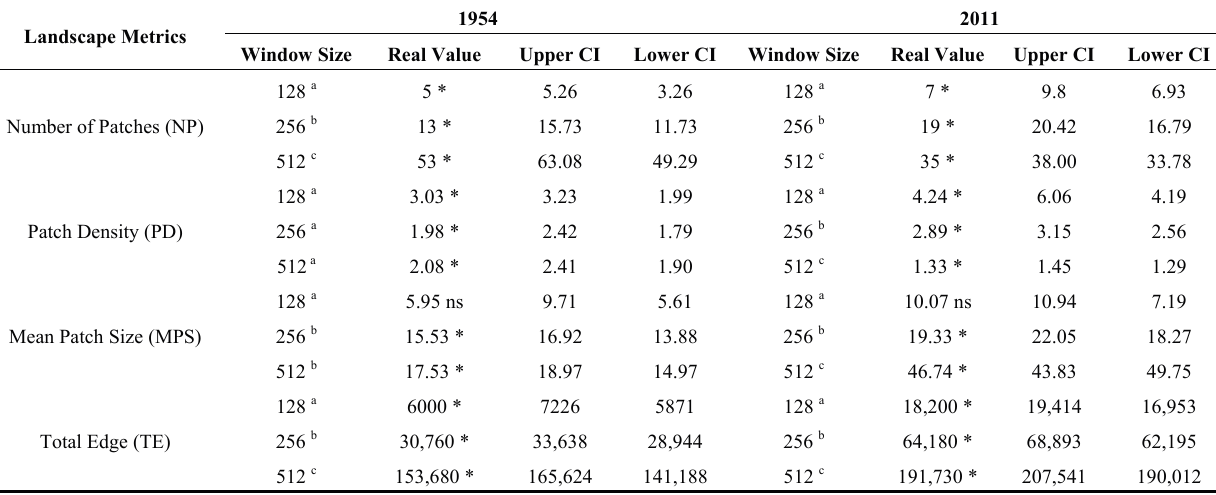
Table 2. Real values of pattern metrics obtained from three different map extents (128 × 128, 256 × 256 and 512 × 512 pixels) and two temporal periods (1954 and 2011) along with the 99% confidence intervals (CIs) obtained by applying bootstrapping procedures (BCa) on specific simulated MRC